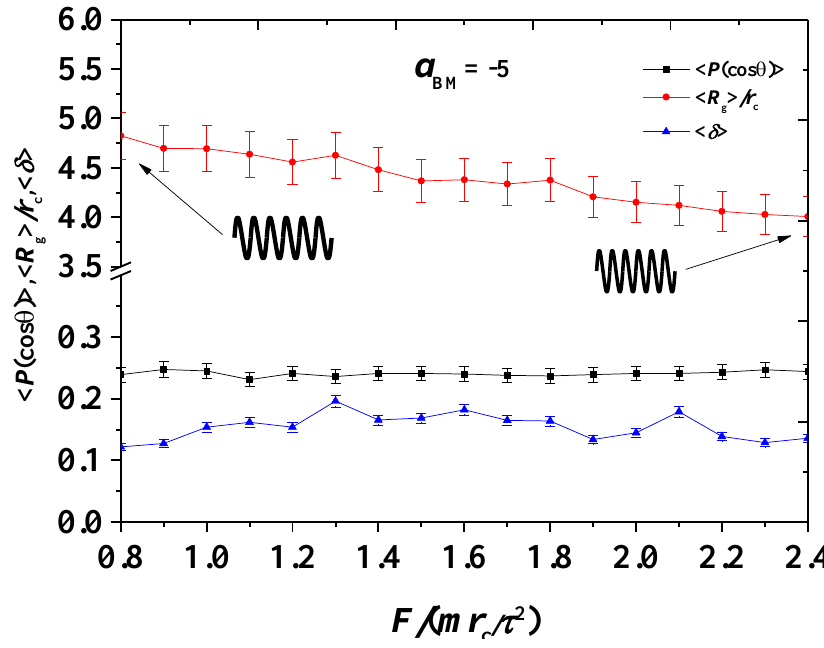
R and average shape g (cid:68) (cid:69) R g and average shape